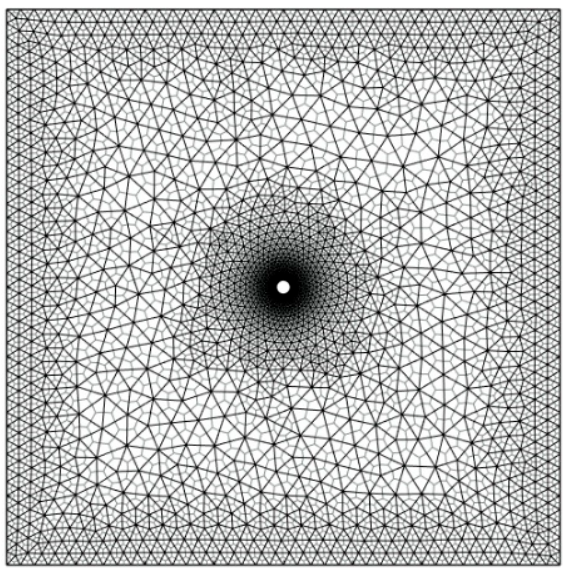
Figure 2. Tessellation of calculation domain.